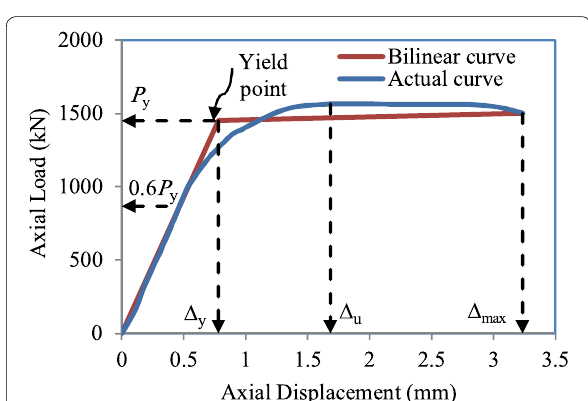
Fig. 4 Bilinear representation of the experimental P –Δ curve of column